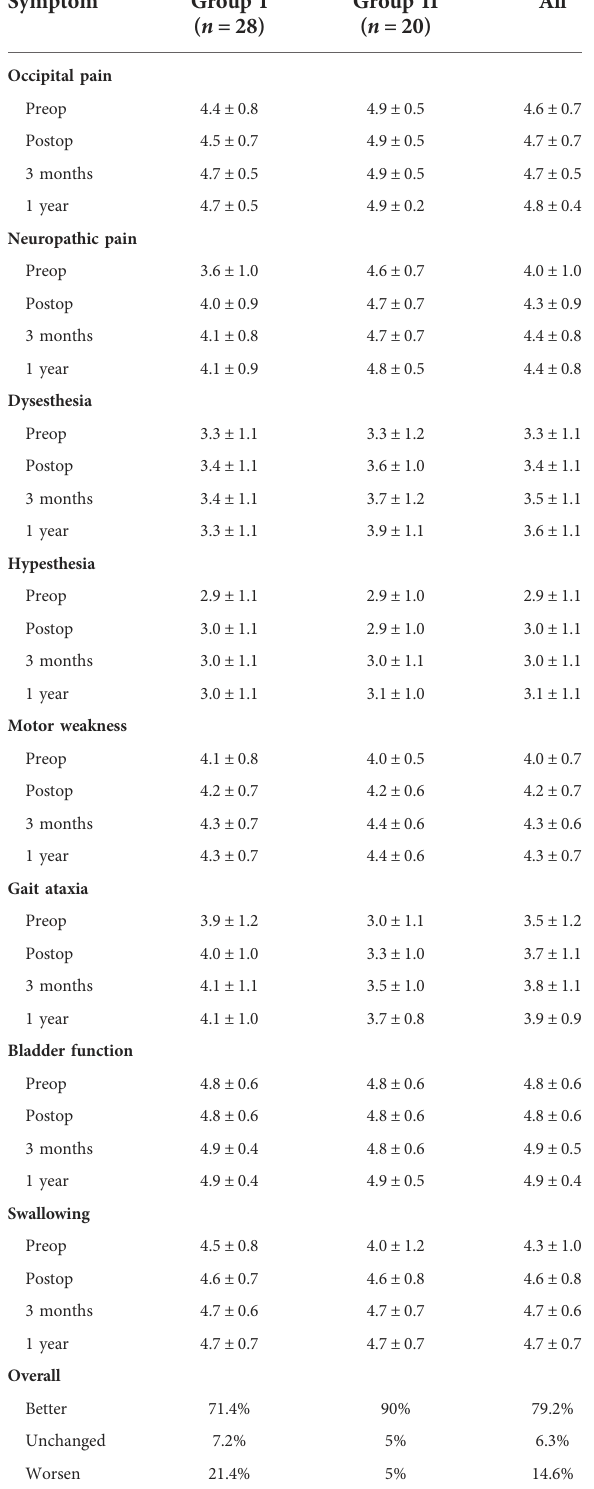
TABLE 2 Neurological course of Group I and II patients after the revision surgery ( n